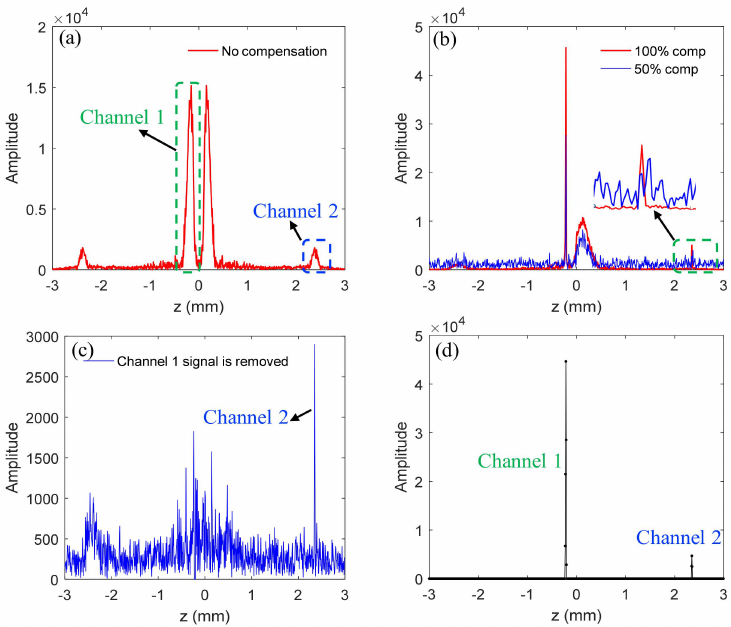
Figure 4. Experiment results of dual-channel SD-OCT system whose sample is a mirror. The red curve in ( a ) is the signal with dispersion. The red and blue lines in ( b ) are the structural signals after numerical dispersion compensation, which are obtained by 100% spectral data and 50% spectral data, respectively. The result in ( c ) is the residual signal with channel 1’s signal removed. The signals in ( d ) are the final reconstructed